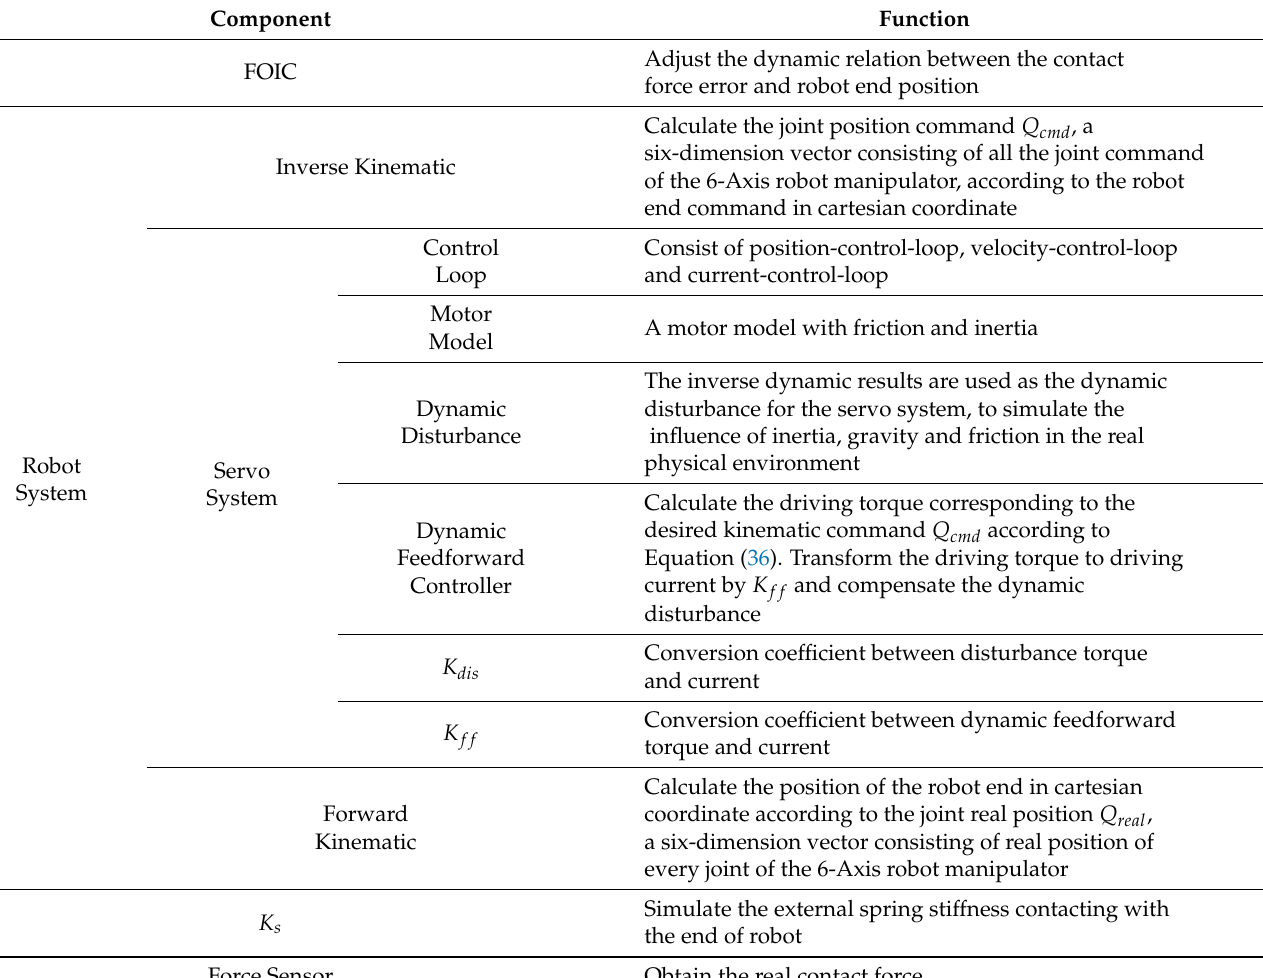
Figure 7. Robot manipulator FOIC simulation system. Table 3. Simulation system components and